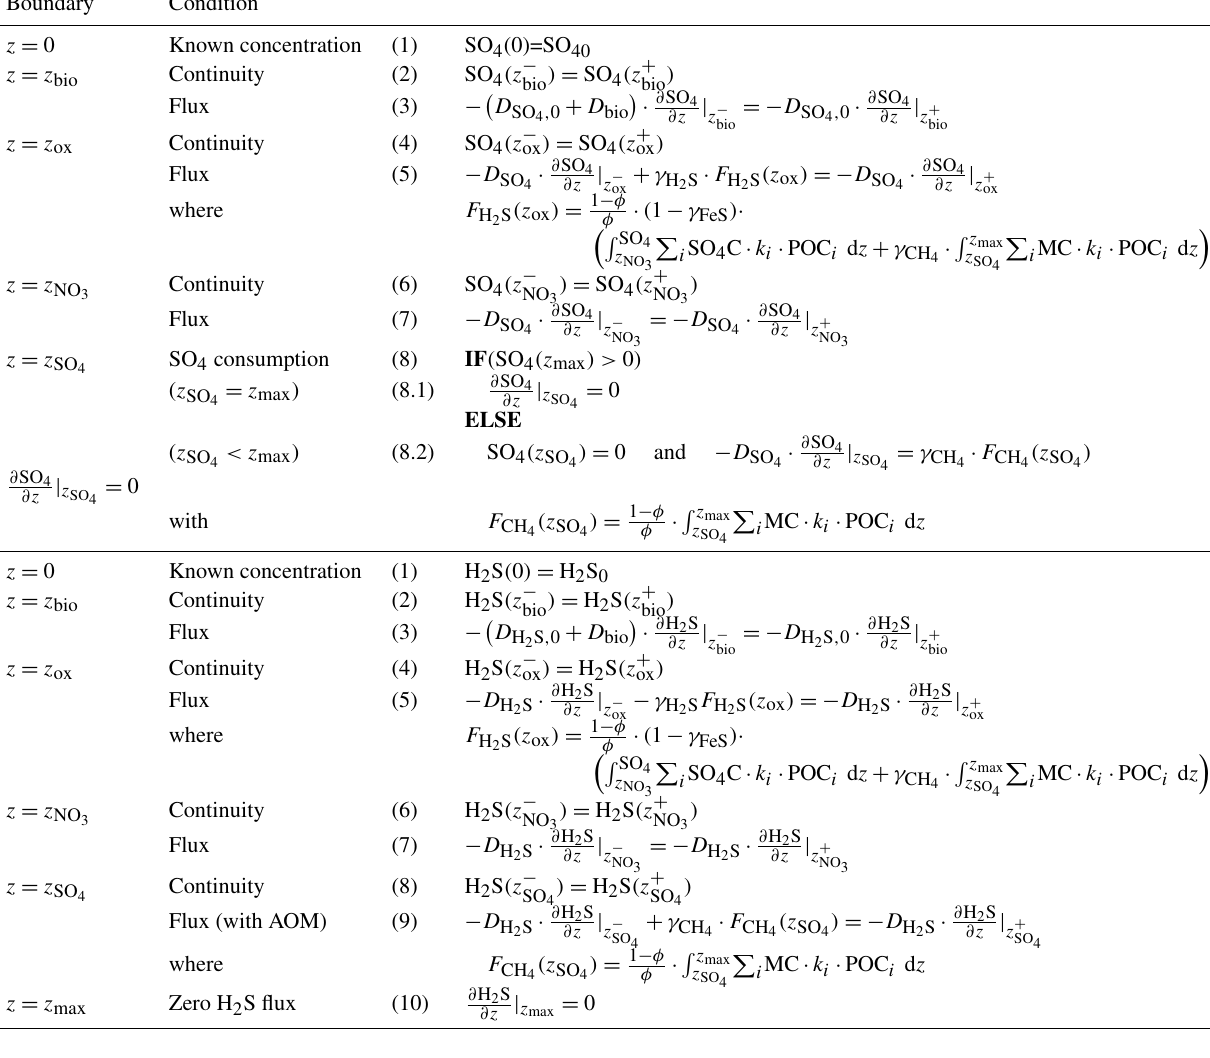
Table 5. Boundary conditions for sulfate and sulfide. For the boundaries we define z − __ = lim h → 0 (z __ − h) and z + __ = lim h → 0 (z __ + h) . Boundary